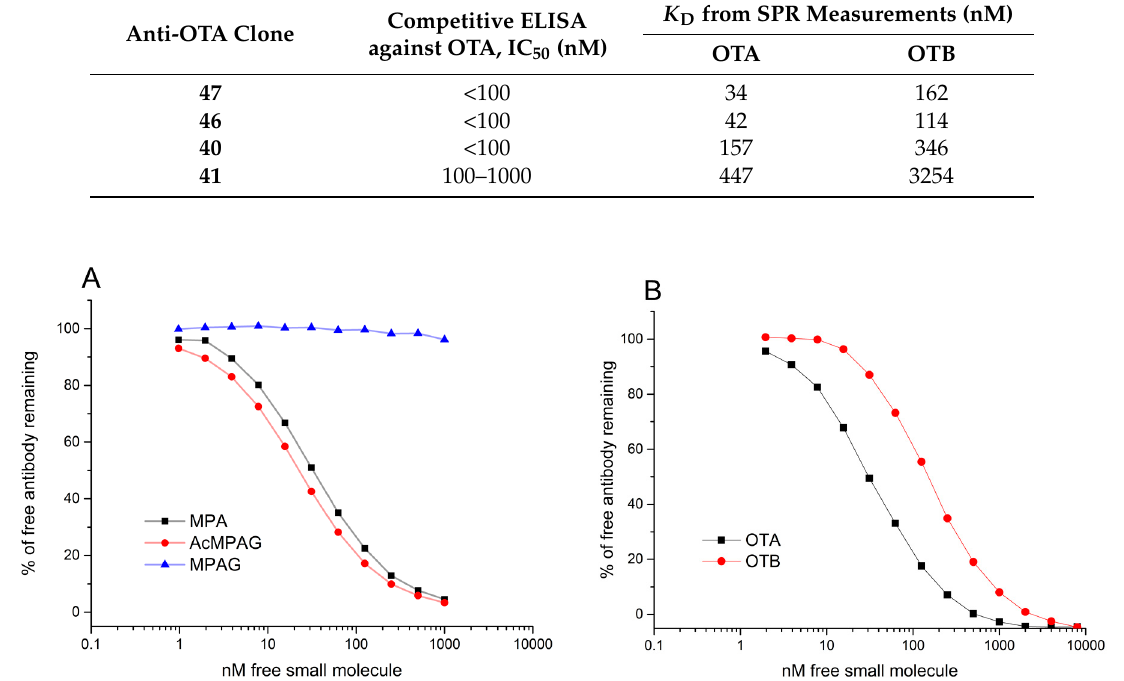
Figure 3. Affinity and specificity determinations of the MPA- and OTA-binding antibody clones having the highest affinities measured with SPR. ( A ) anti-MPA antibody (MPA14) competition against MPA, AcMPAG, and MPAG; ( B ) Anti-OTA antibody (OTA47) competition against OTA and OTB. Data derived from duplicates. Drawn with OriginPro 2015 (OriginLab, Northampton, MA, USA).